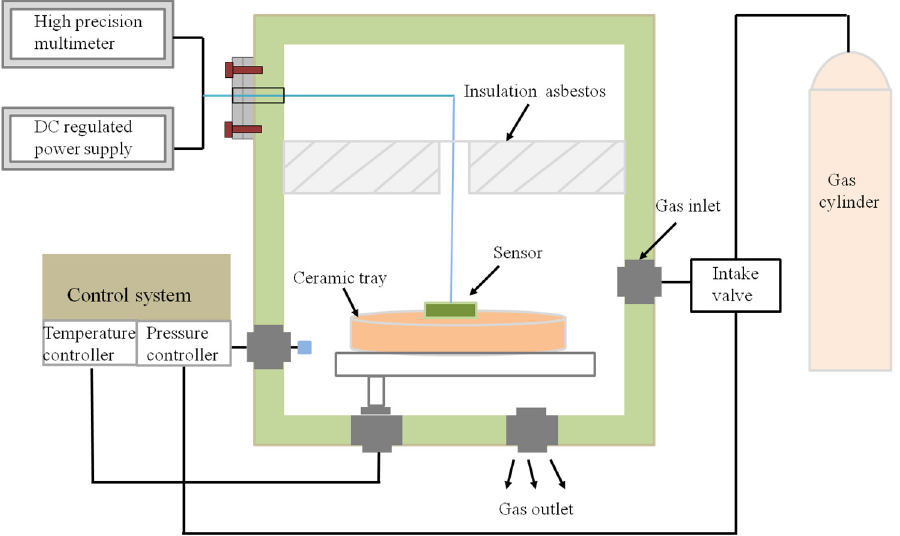
Figure 4. The force-sensitive measurement system.